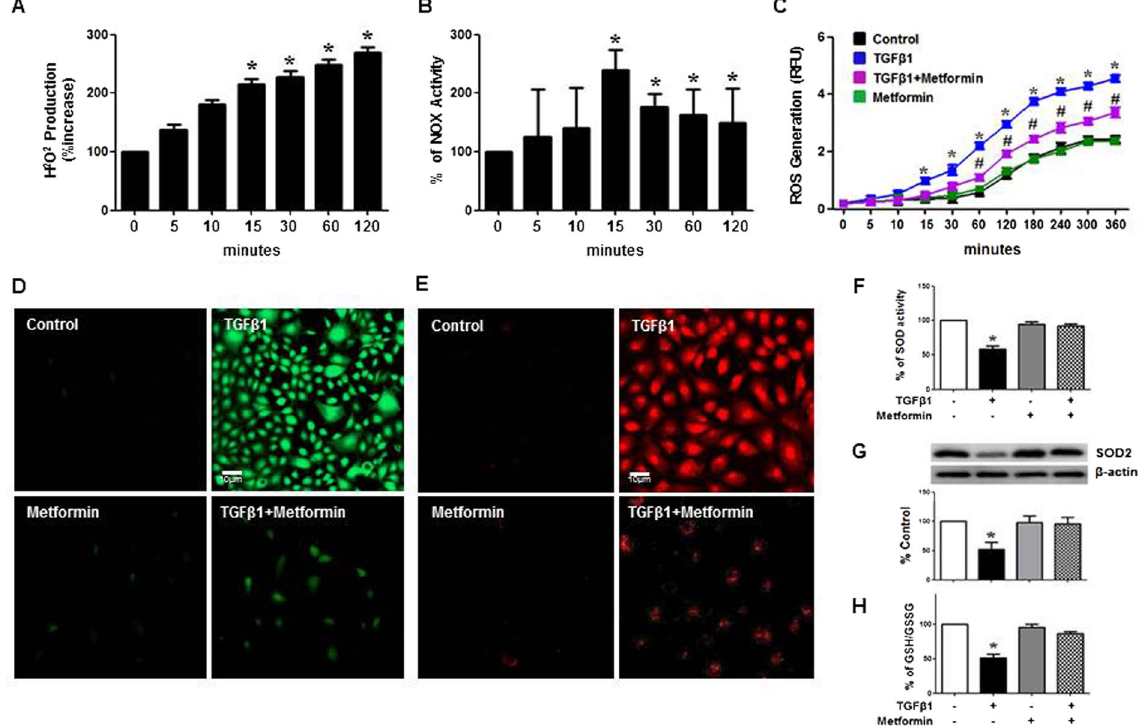
Figure 5. Effect of Metformin on TGF- β -induced Oxidative Stress. TGF- β 1 increases H 2 O 2 generation ( A ) with an enhanced activity of NOX ( B ) from 15 minutes. Metformin blocks ROS generation ( C ) assessed by DCF-DA staining (green) at 30 minutes ( D ) and Mito-SOX staining (red) at 6 hours ( E ). (n = 6). TGF- β 1 decreases the activity of superoxide dismutase (SOD) ( F , 6 hours) and the expression of SOD2 ( G , 6 hours) and a release of reduced glutathione (GSH/GSSG) ( H , 6 hours) in HPMCs, which was restored by metformin. Representative western blots with quantitation bar ( G ) (n = 6) are shown. * p < 0.05 vs. time points of 0, 5 and 10 minutes, # p < 0.05 vs. control, TGF- β 1 or metformin, † p < 0.05 vs.